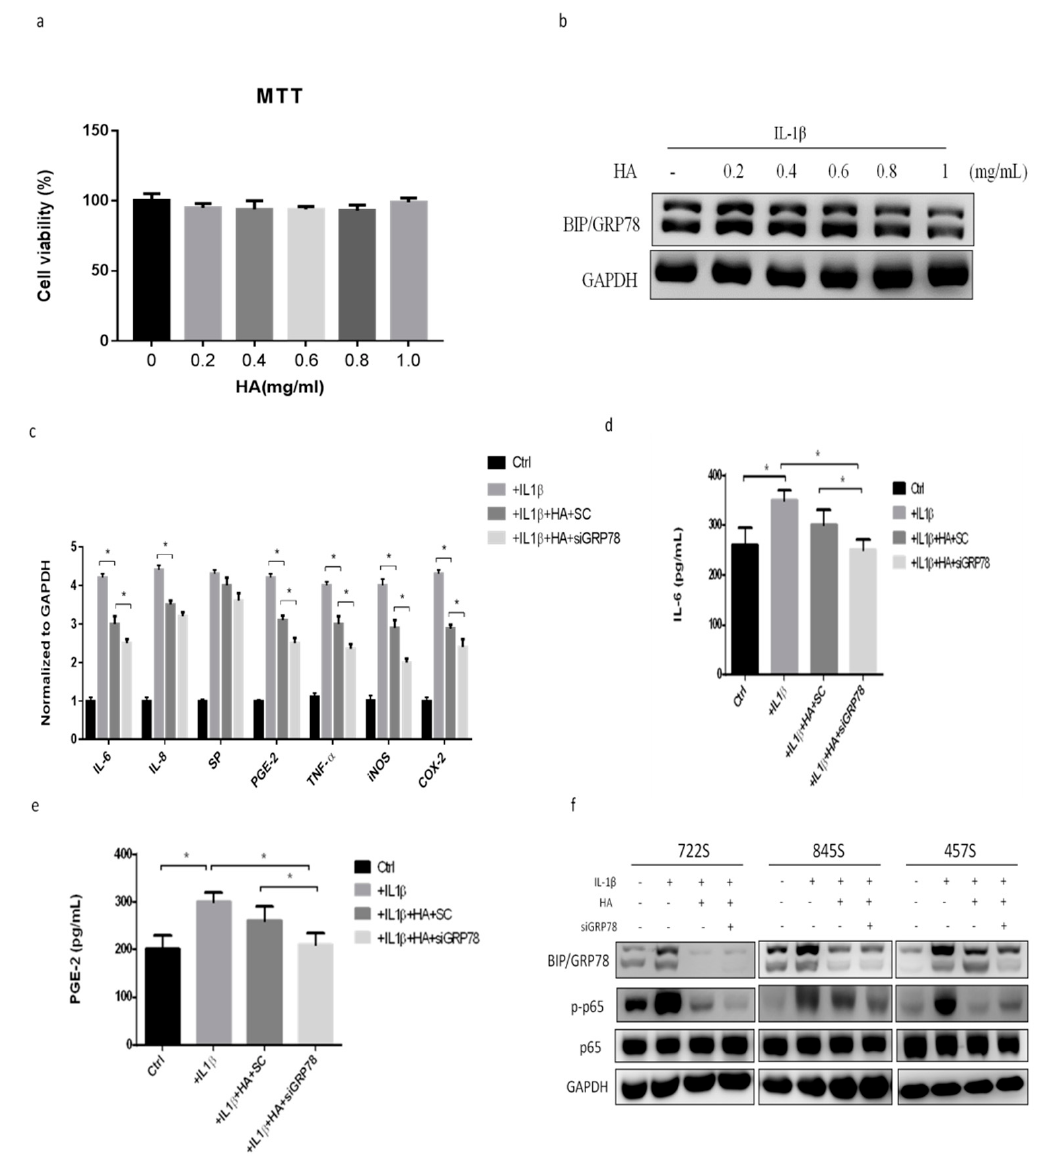
Figure 5. Effects of HMW-HA treatment on inflammatory factors and GRP78 in primary synoviocytes: ( a ) The primary synoviocytes were dose-dependently treated with HMW-HA for 24 h, and then, cell viability was assessed using the MTT assay. ( b ) The primary synoviocytes treated with IL − 1 β plus HMW-HA in a dose-dependent manner for 24 h and Western blot analysis of GRP78. ( c ) The primary synoviocytes were treated with IL − 1 β plus HMW-HA with siGRP78. Quantitative PCR analysis of IL − 6, IL − 8, SP, PGE − S, TNF − α , iNOS, and COX2. ( d , e ) ELISA analysis of IL − 6 and PGE2. ( f ) Western blot analysis of GRP78, p65 phosphorylation, and p65. Data are expressed as a mean ± SD, * p < 0.05. The data presented are representative of three independent experiments.